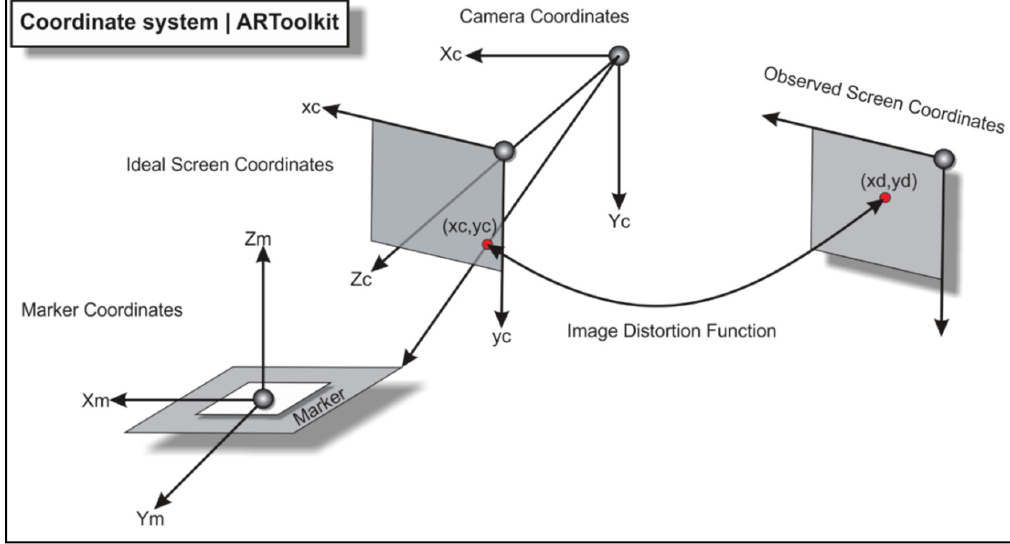
Figure 1. Coordinate systems used in processing with ARToolKit. (Developed by the authors).